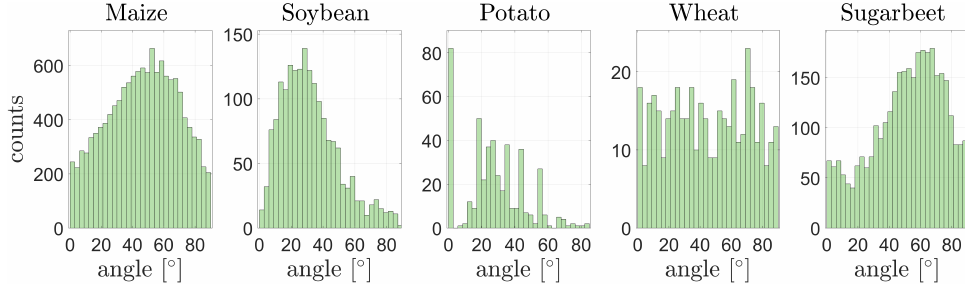
Figure 13. Leaf inclination angle distribution computed for the leaf point clouds of maize, soybean, potato, wheat, and sugar beet of Figure 8. The inclination angles are computed by using the pipeline shown in Figure 4.